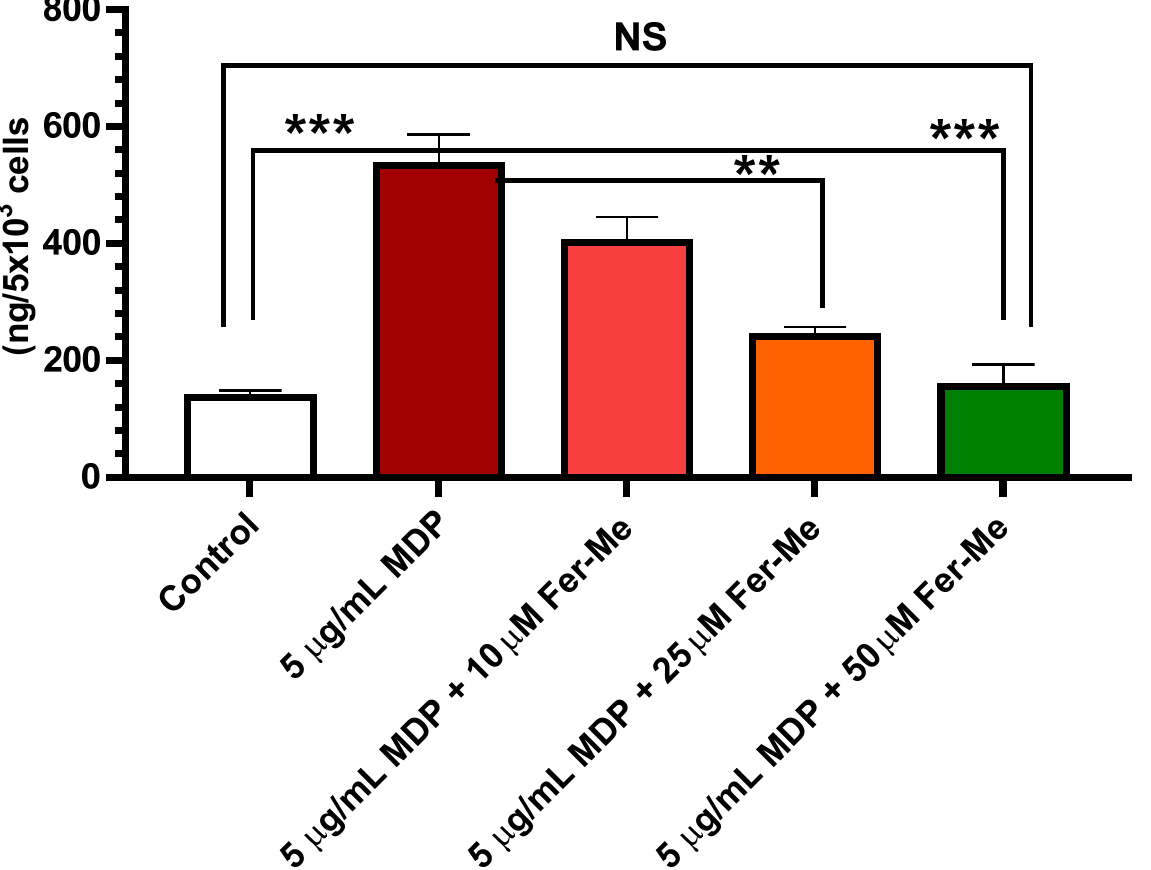
Figure 4. Fer-Me counteracts the release of the pro-inflammatory cytokine TNF- α evoked by 5 µg/mL MDP. PC12 cells were treated by MDP, or MDP plus increasing concentrations of Fer-Me, for 24 h. The concentrations of TNF- α in the culture supernatant were measured by ELISA. ** p < 0.01; *** p < 0.001. Results are reported as the mean ± S.E.M. of four independent experiments.